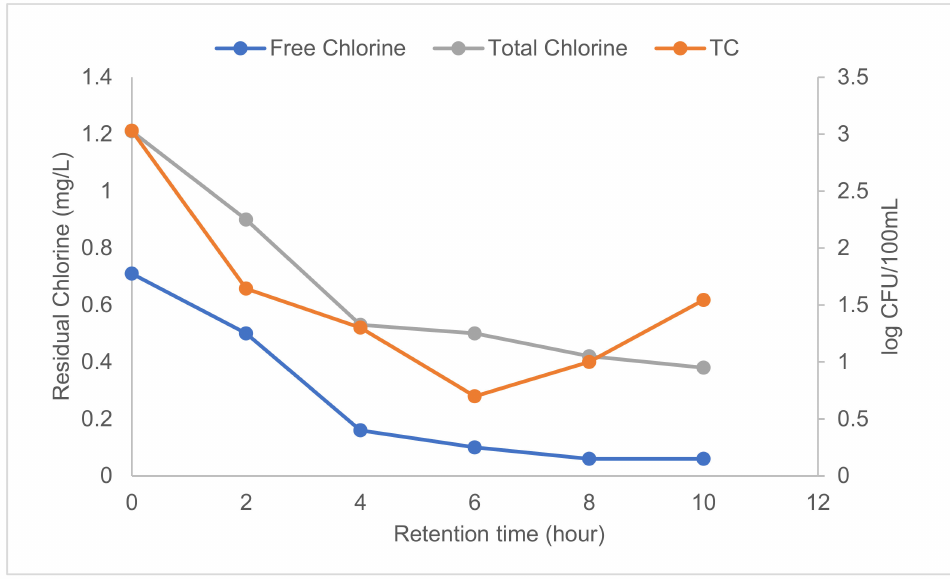
Figure 13. Change in concentration of TC, free chlorine, and total chlorine in treated water. The TC concentration decreased from 3.0 to 0.7 log 10 CFU/100 mL (1070 to 5 CFU/100 mL) in 6 h. In addition to TC concentration, the concentration of free chlorine and total chlo- rine decreased from 0.7 to 0.1 mg/L and from 1.2 mg/L to 0.5 mg/L, respectively. The concentration of TC then increased to 1.5 log 10 CFU/100 mL (35 CFU/100 mL) with free chlorine below 0.1 mg/L and total chlorine below 0.5 mg/L after 6 h. The log reduction value (LRV) of E. coli was calculated as more than 1.5, while that of TC ranged from 1.4 to 2.3. The turbidity in the treated water was 2, 2, 1, 3, 0, and 0 NTU in 0, 2, 4, 6, 8, 10